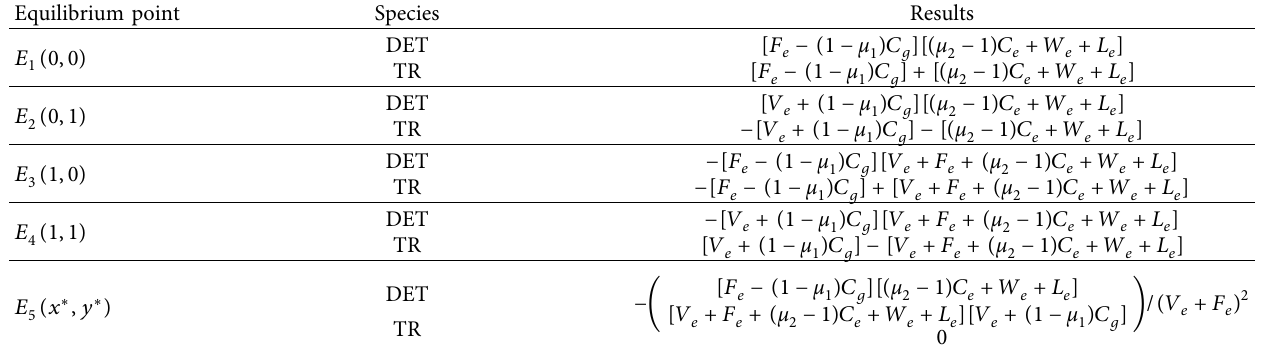
Table 2: Matrix determinants and traces of equilibrium points.